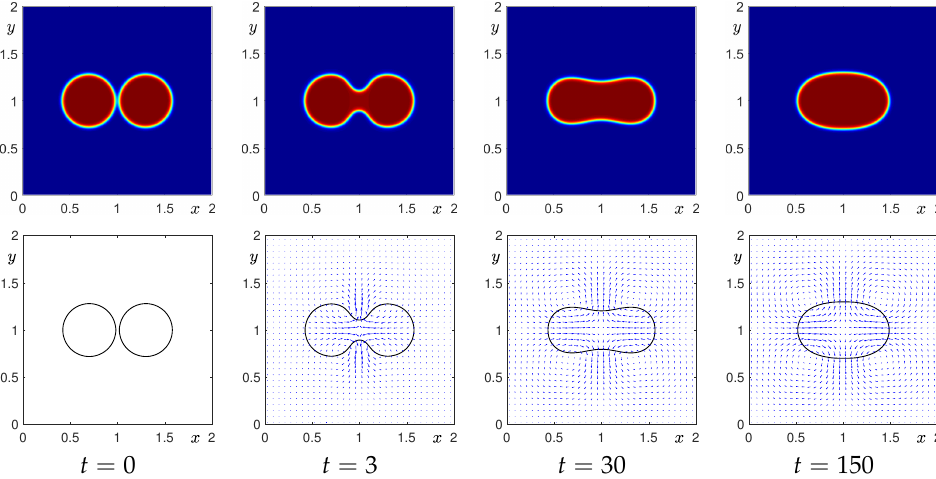
Figure 3. Snapshots of φ and velocity field are shown in the top and bottom rows. The computational moments are illustrated under each